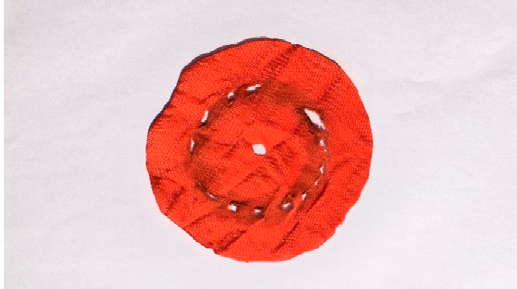
Figure 8. Fabric dyed with no silicone softener.